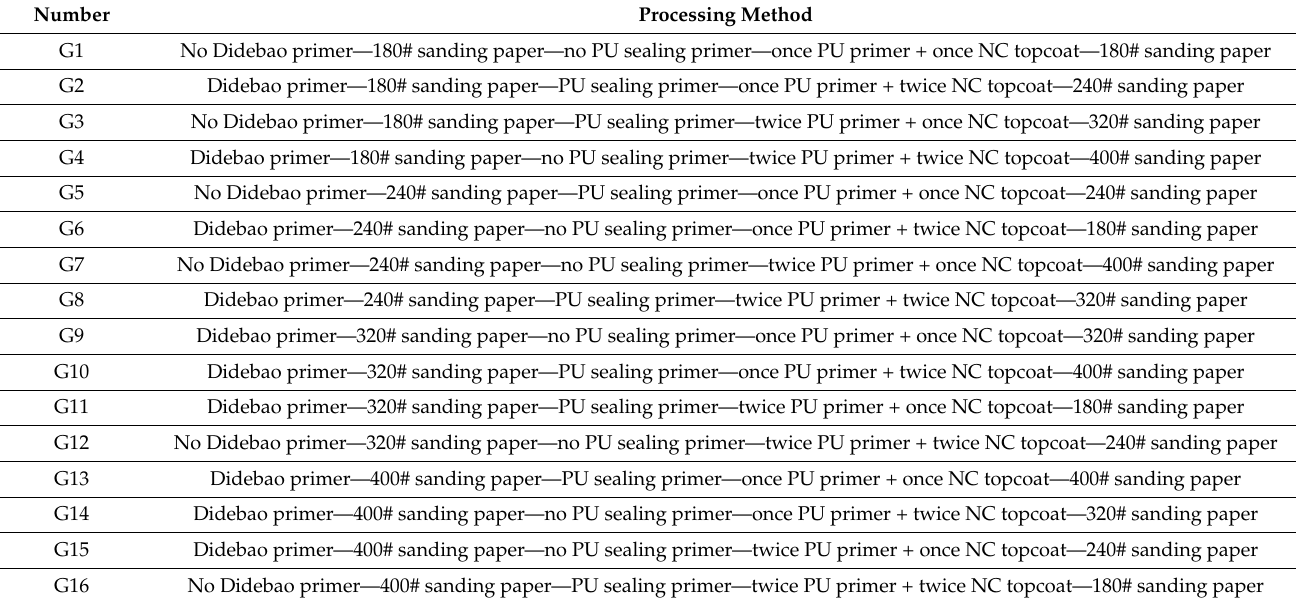
Table 3. Processing